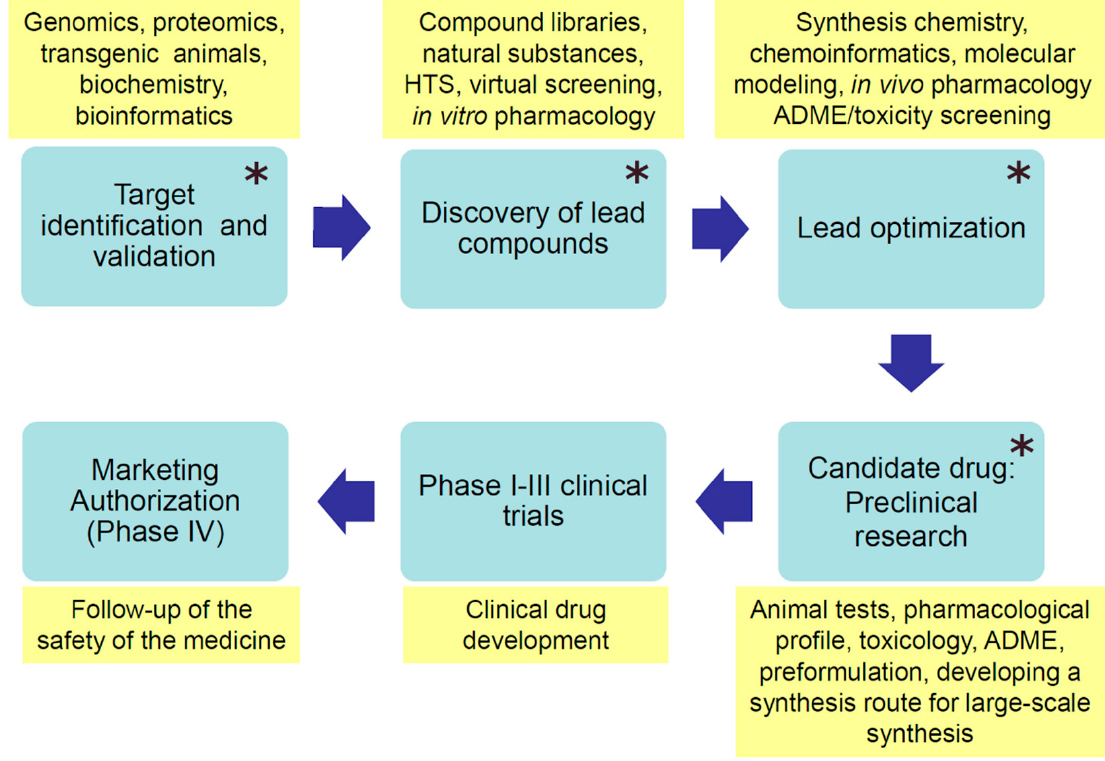
Figure 2. Phases of modern drug development (blue boxes). The yellow boxes contain characteristic actions, methods, or tools used in the particular development phase. ADME—absorption, distribution, metabolism, and excretion; main steps of a drug in the body. Molecular dynamics simulations can be applied to facilitate research in the phases denoted with a star (*).